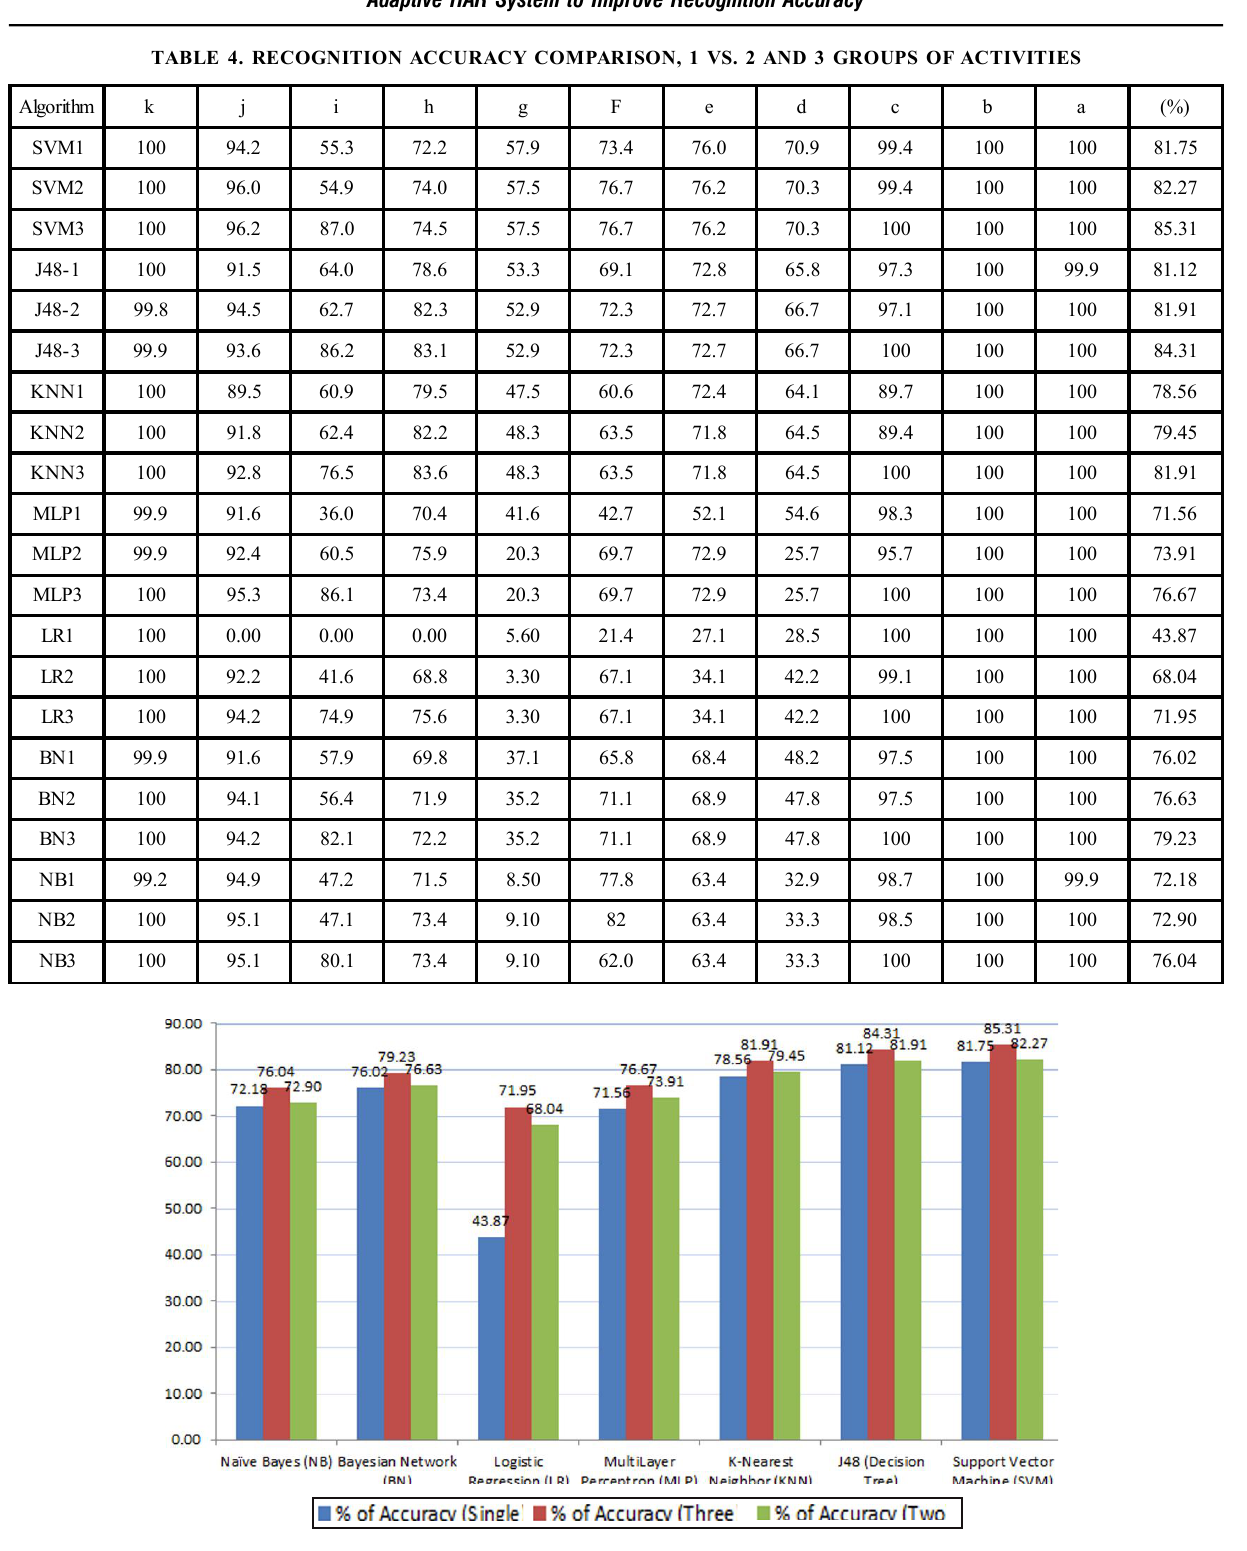
FIG. 8. RECOGNITION ACCURACY COMPARISON, 1 VS. 2 AND 3 GROUPS OF